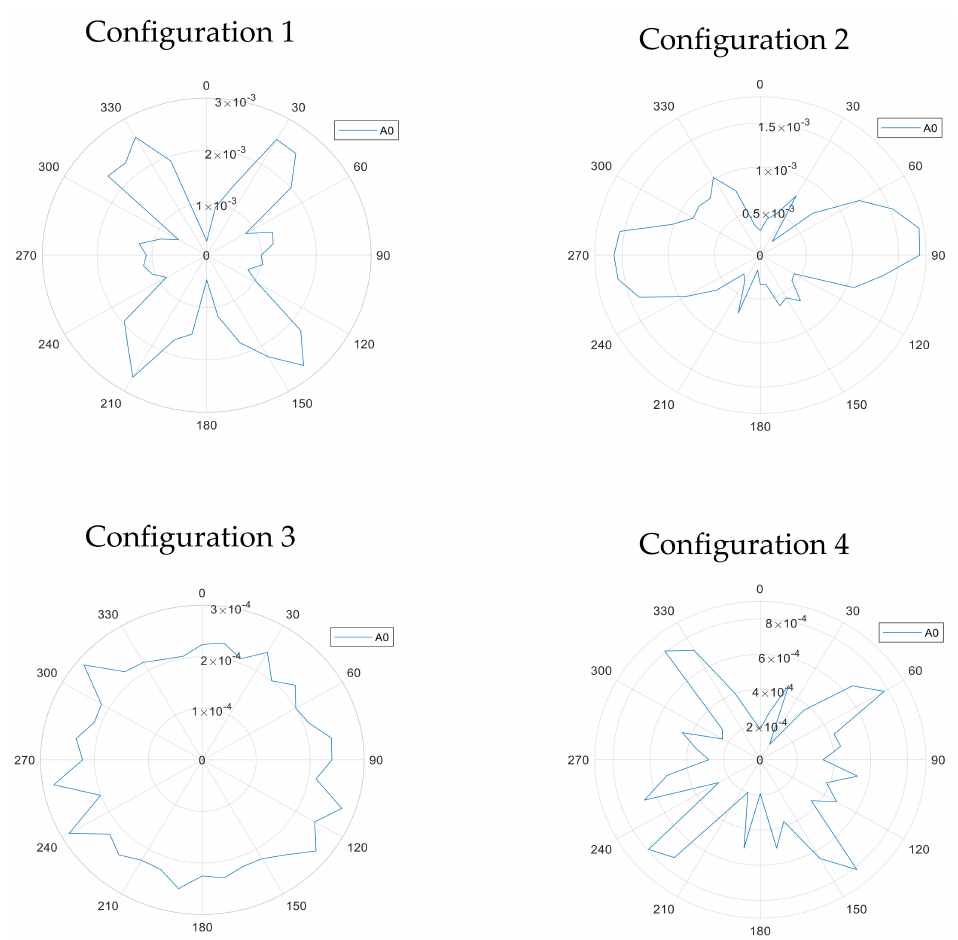
Figure 15. Directivity patterns for the A0 mode generated on the metallic plate for the four di ff erent configurations (1, 2, 3 and 4 as labelled in the